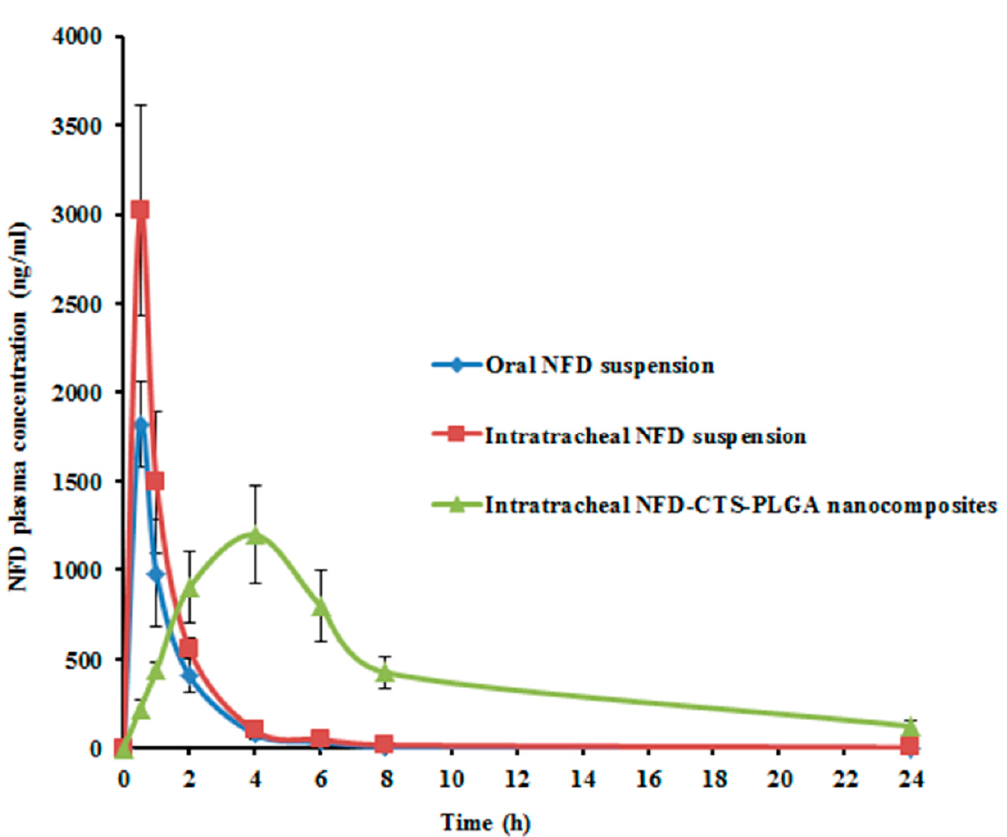
Figure 5. Mean NFD plasma concentrations in rats following administrations of oral and intratracheal suspensions as well as intratracheal optimized nanocomposites. Each value denotes the mean ± SD ( n = 6).